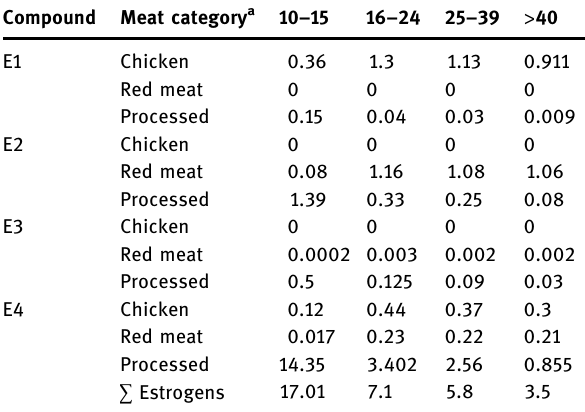
Table 7: EDI, µg/kg bw/day, of estrogens through the consumption of meat - based food products by the Saudi adult based on di ff erent age groups ( years ) Compound Meat category a 10 –